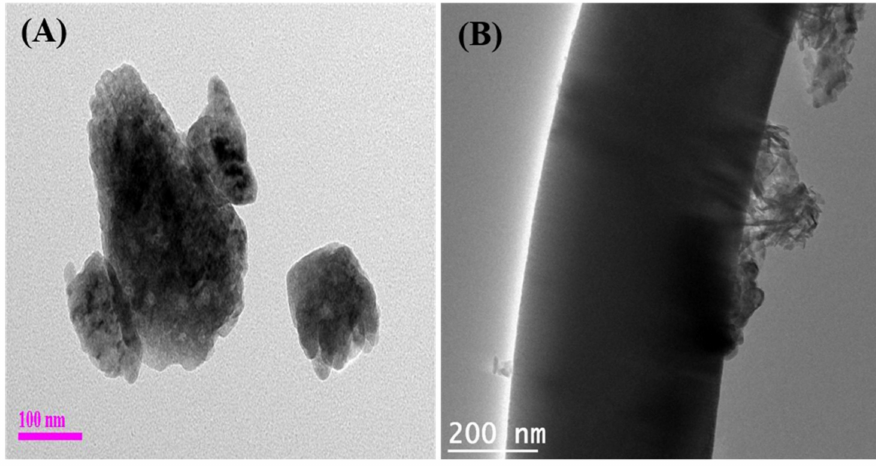
Figure 3. TEM image of ZnO particle ( A ) and ZnO-TiO 2 -CNFs composite ( B ).